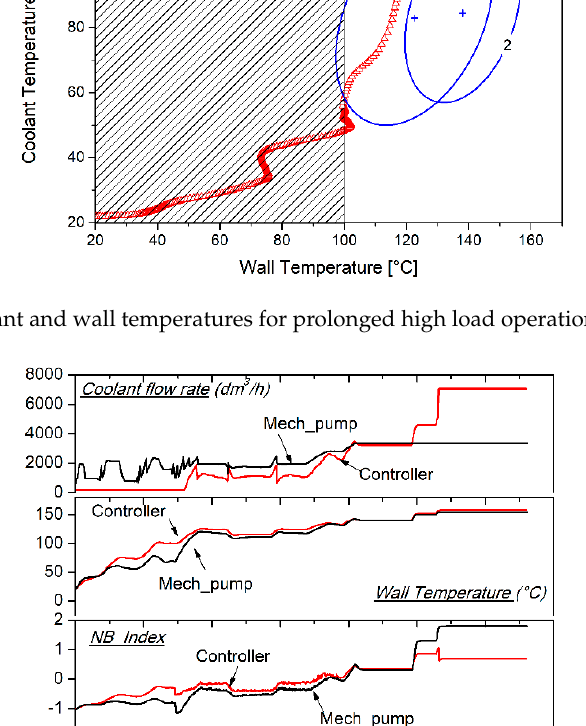
Figure 26. Controlled coolant flow rate ( top ), average wall temperature ( middle ), and NB_Index ( bottom ) for prolonged high load operation ( 𝑚(cid:4662) (cid:3033) = 18 kg/h).